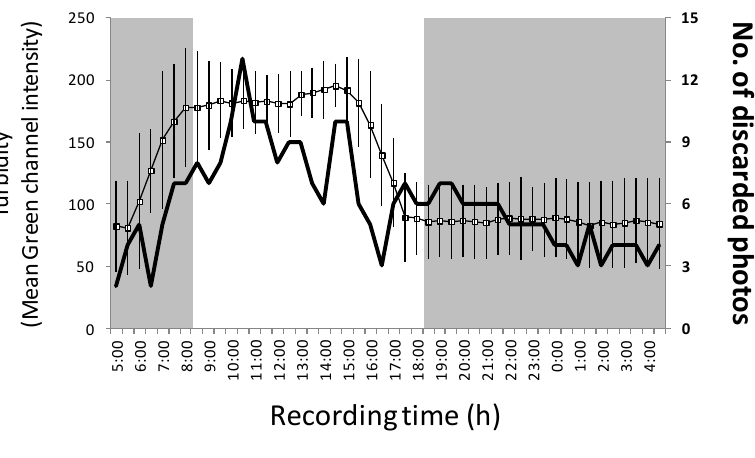
Figure 8. The influence of turbidity on the elaborated automated video-imaging protocol over a standard 24-h cycle, as indicated by turbidity as quantified through the averaged Green content (green-channel) and total discharged photos. Grey area is the